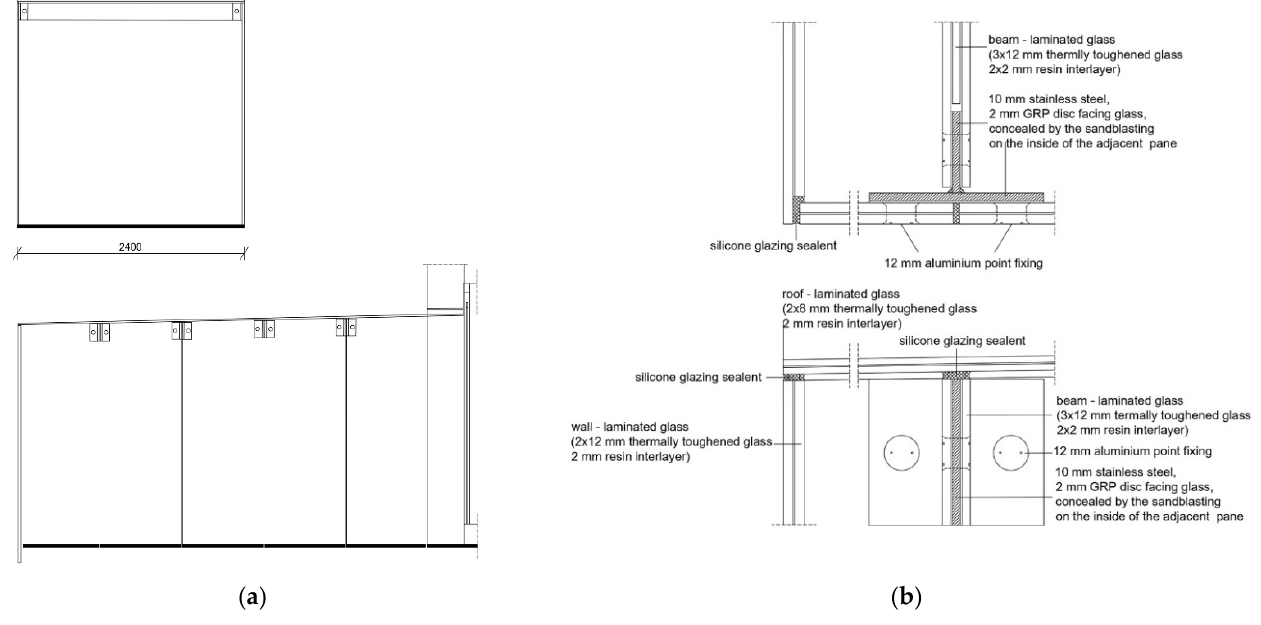
Figure 25. House at King Henry’s Road in London: ( a ) cross-section and longitudinal section through extension; ( b ) detail of supported glass beam in the shear wall (figures by the author).